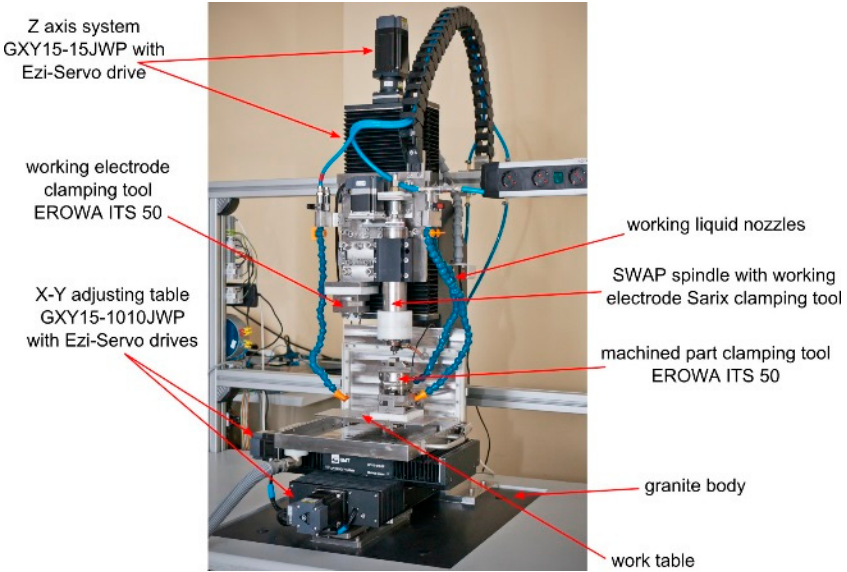
Figure 3. Electrochemical/electrodischarge hybrid micromachining machine prototype [13].